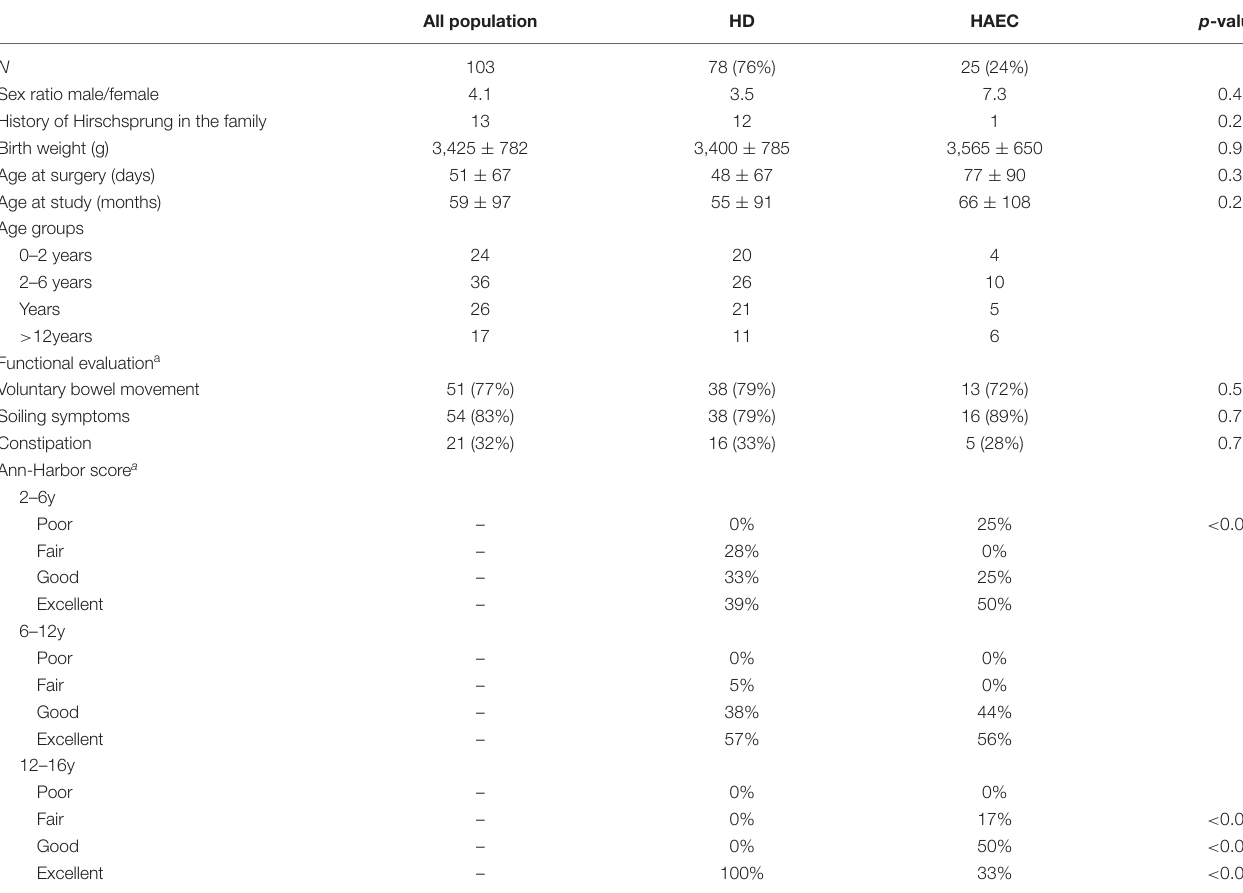
TABLE 1 | Patients’